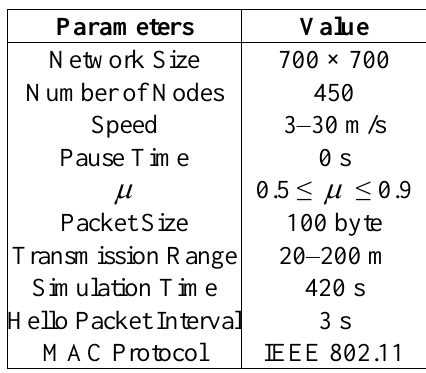
Table 3. Simulation